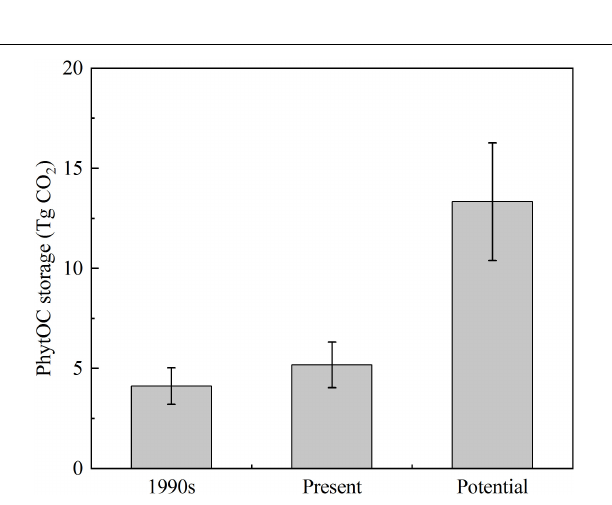
FIGURE 3 | Proportion of PhytOC storage in litter layers of different forests.